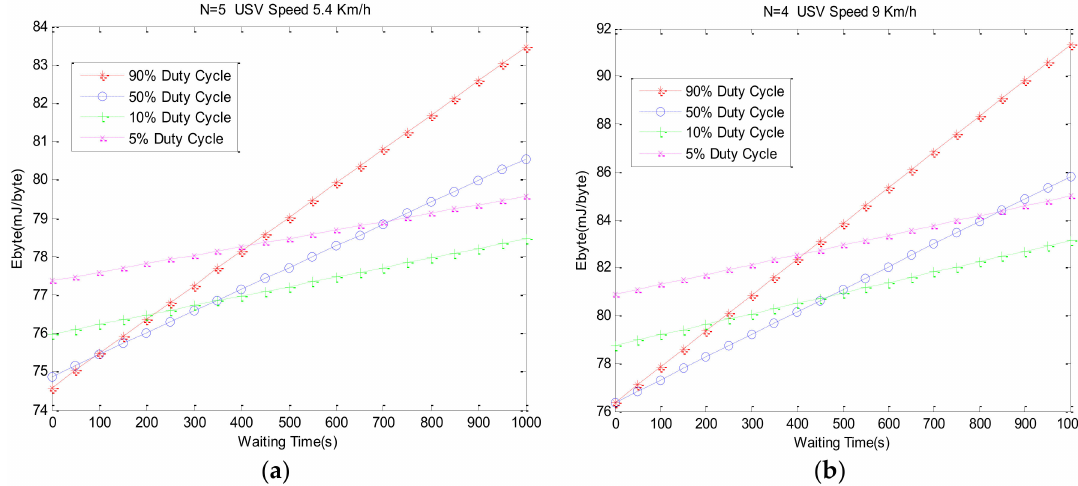
Figure 12. Energy consumption simulation under different waiting